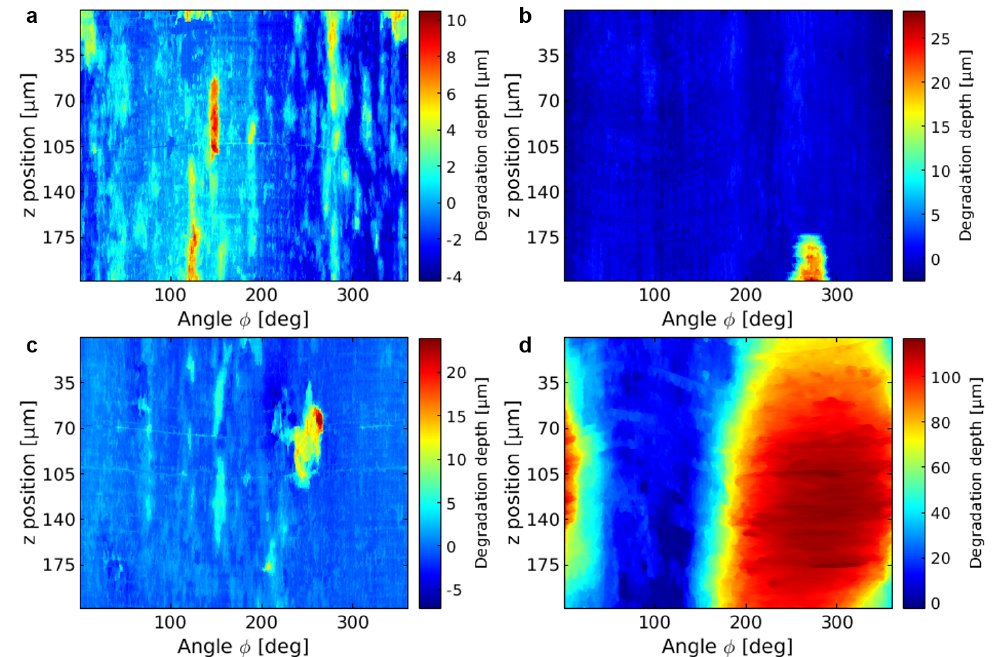
Figure A1. Exemplary heat maps of the localised degradation depth of four wires following radial reslicing. ( a ) displays the recrystallized Mg-6Ag wire after 3 days of immersion, which resulted in a negative degradation rate and pitting factor ( − 0.05 mm/yr and − 33.6, respectively). ( b ) shows the wire with the highest pitting factor of 421.4, which was found for a solution annealed Mg-6Ag wire after 3 days of immersion, due to the low overall degradation. ( c ) displays a recrystallized Mg-6Ag wire after 3 days of immersion with low degradation rate (0.06 mm/yr) and high pitting factor (68.9). ( d ) shows a recrystallized Mg-6Ag wire after 3 days of immersion with high degradation rate (6.45 mm/yr) and lower pitting factor (1.9.)